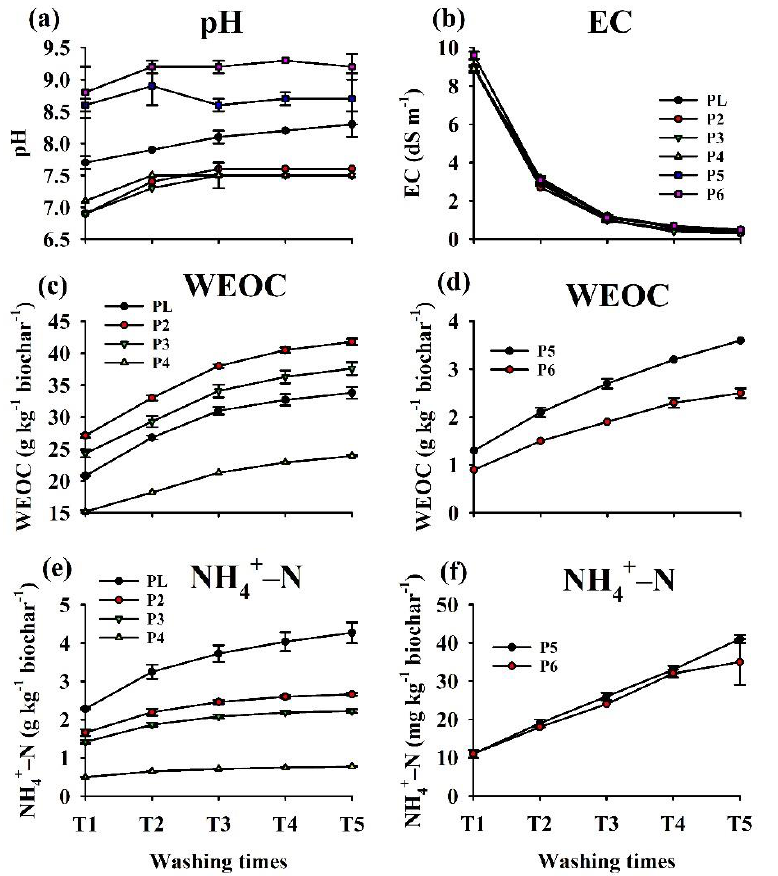
Figure 1. The values of ( a ) pH and ( b ) electrical conductivity (EC), and concentrations of ( c , d ) cumulative organic C and ( e , f ) ammonium nitrogen ( NH 4+ – N ) extracted from PL, P2, P3, P4, P5, and P6 (PL pyrolyzed at 200 °C, 300 °C, 400 °C, 500 °C, and 600 °C, respectively) biochar by water 5 times. Error bars represent standard deviations from the mean ( n = 3).